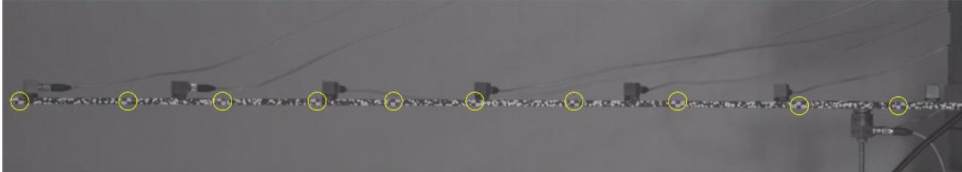
Figure 6. Cantilever beam investigated in the laboratory